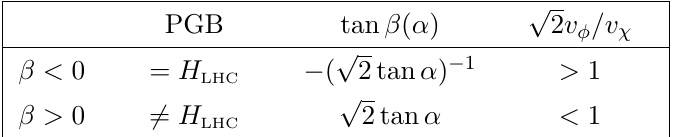
Summary of di(cid:11)erences between positive and negative scalar mixing angle (cid:12) 2 ( (cid:0) (cid:25)= 4 ; (cid:25)= 4). The assignment in the (cid:12)rst column is done according to the discussion right